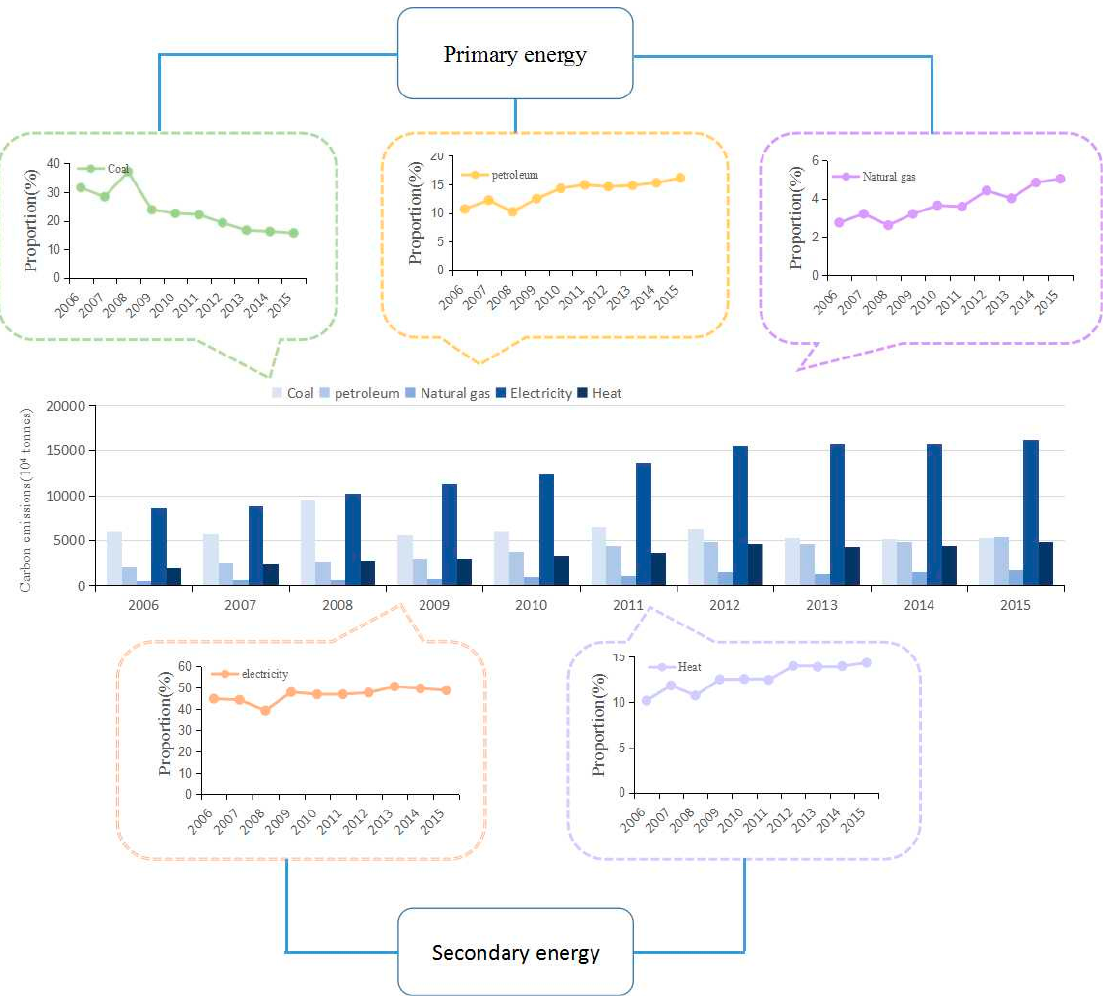
Figure 4. The contribution of five energy sources to the energy carbon emissions of China’s household consumption. household